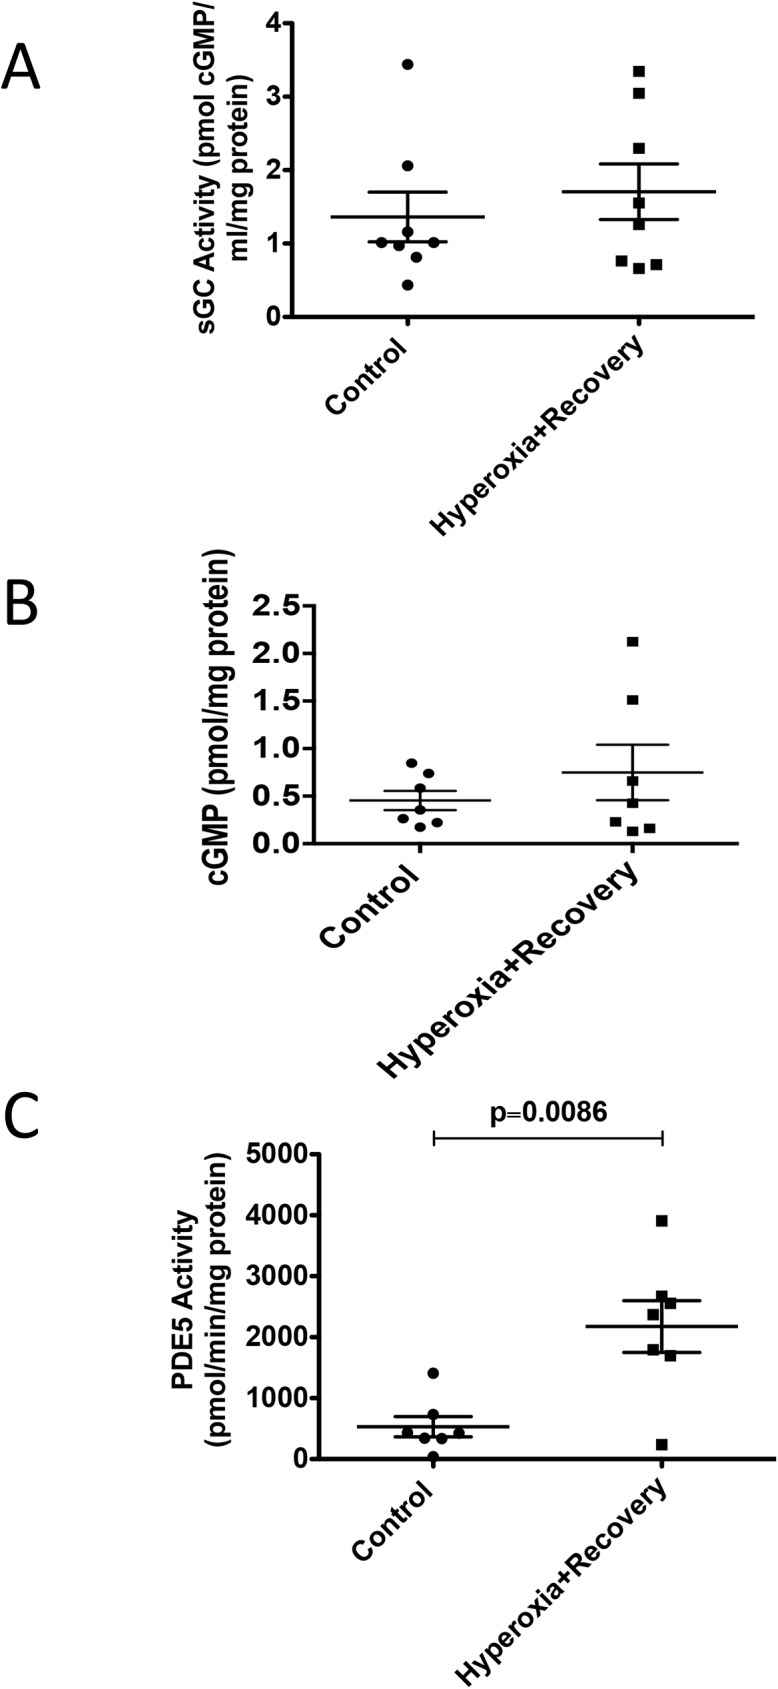
Neonatal hyperoxia exposure is associated with persistent abnormalities in pulmonary artery cGMP signaling.Mice were exposed to hyperoxia or room air for 14d, followed by recovery in room air for an additional 7d (21d). (A) sGC activity was measured as previously described [6] (n = 8 animals per group). (B) PA lysates were assayed for cGMP by enzyme-linked immunoassay, and cGMP was normalized for milligrams of total protein (n = 7 animals per group). (C) PDE5 specific activity was measured as the sildenafil-inhibitable fraction of total cGMP hydrolysis, normalized for total milligrams of protein (n = 7 animals per group). Data are expressed as dot plots with each dot representing individual animals with means and SEM represented by horizontal lines. Results were analyzed using an unpaired t-test.